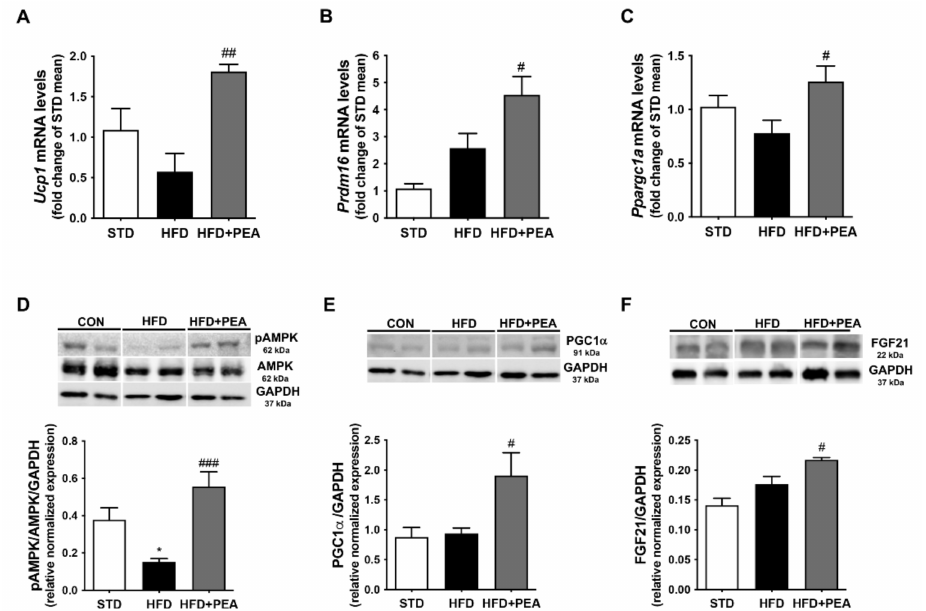
Figure 3. PEA induces white-to-beige tissue markers in scWAT of obese mice. mRNA transcription levels of ( A ) Ucp1 , ( B ) Prdm16 and ( C ) Ppargc1a of all groups are examined (n = 5–6). Protein expressions of ( D ) phospho-AMPK, ( E ) PGC1 α and ( F ) FGF21 in scWAT of all animals are analyzed (n = 6). Results are shown as mean ± SEM. * p < 0.05, significantly different from STD; # p < 0.05, ## p < 0.01, ### p < 0.001 from HFD.